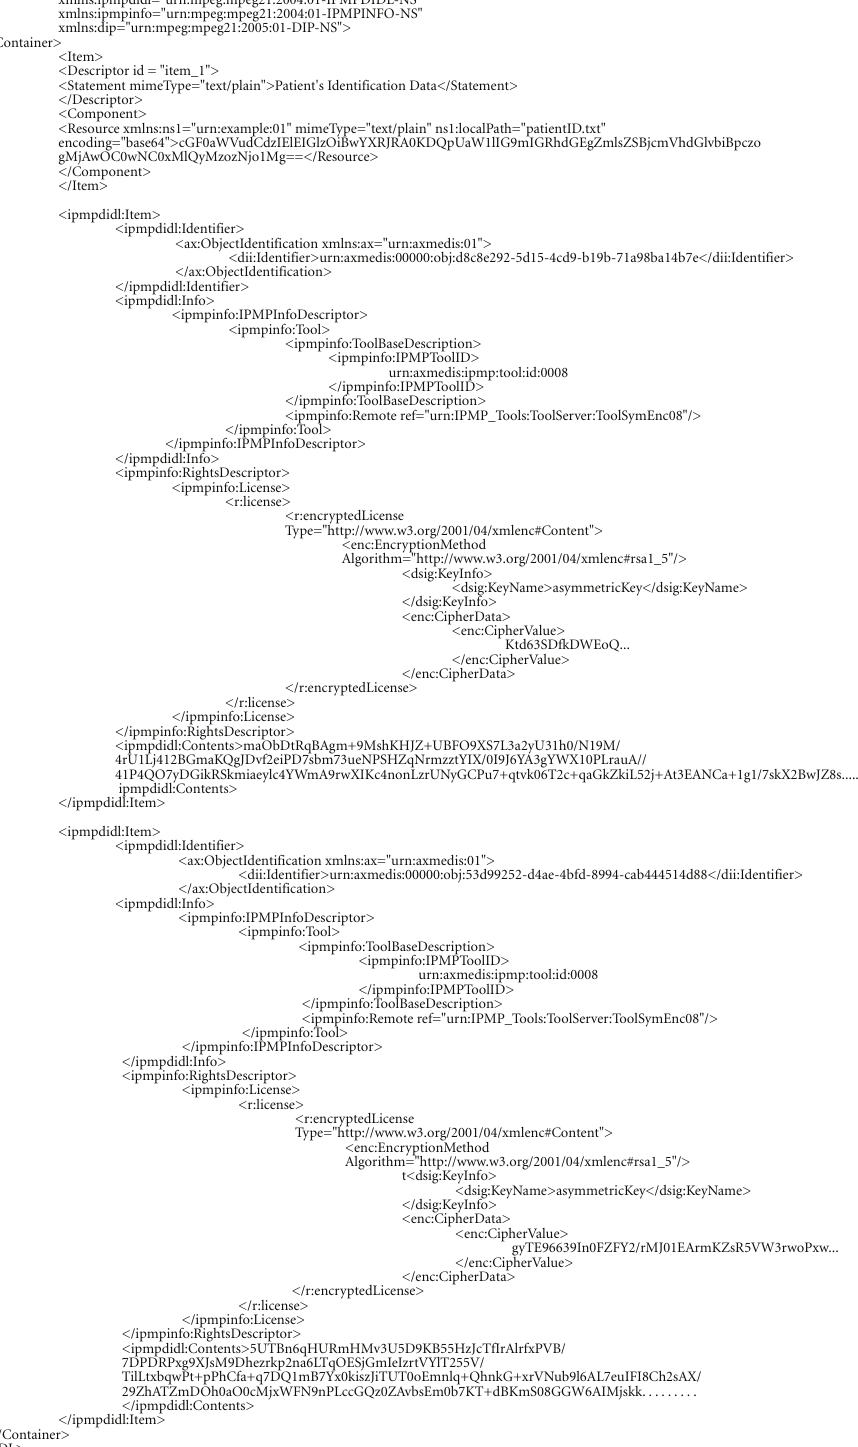
Figure 9: An example view of an MPEG-21 IPMP container which contains three items—one not protected and two protected with the use of a cryptographic tool that is remote referenced at the location urn:IPMP Tools:ToolServer:ToolSymEnc08. Before the user decrypts the contents, he must decrypt the license that accompanies the content, which will provide to the user the decryption key and usage rules of the content. The license is binded to a specific user and it is included into the item encrypted using a public-key algorithm; in our implementation, we used RSA [11], and the license has been encrypted using the users’ public key. For the creation of the aforementioned MPEG-21 IPMP-based file, we have used the AXMEDIS editor